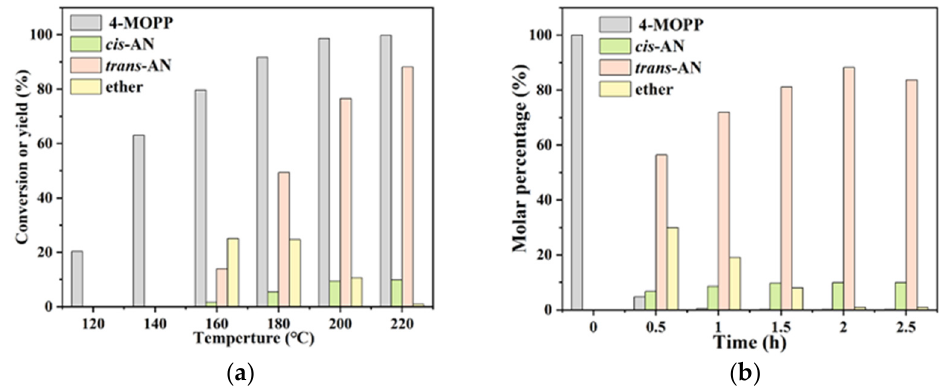
Figure 8. Influence of the reaction ( a ) temperature; ( b ) time on the 1 mmol 4-MOPP, 10 mL 2-pentanol, 0.1 g PhP-Hf (1:1.5) catalyst.